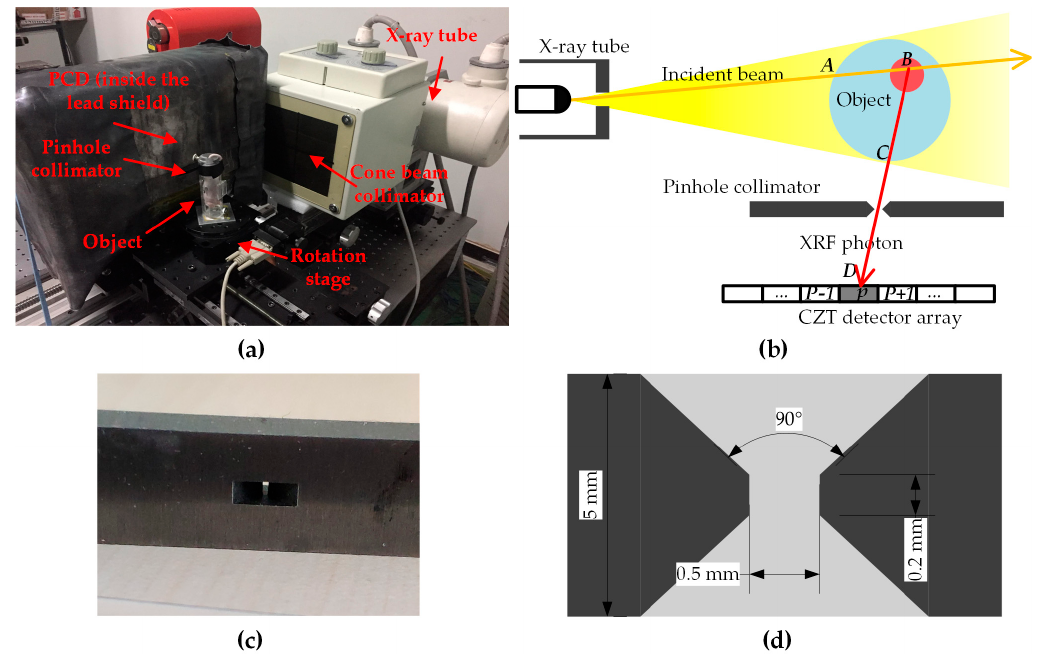
Figure 6. ( a ) The benchtop XFCT device; ( b ) The transport process of the x-ray fluorescence (XRF) signal; ( c ) The front view of the pinhole; ( d ) The cross section of the